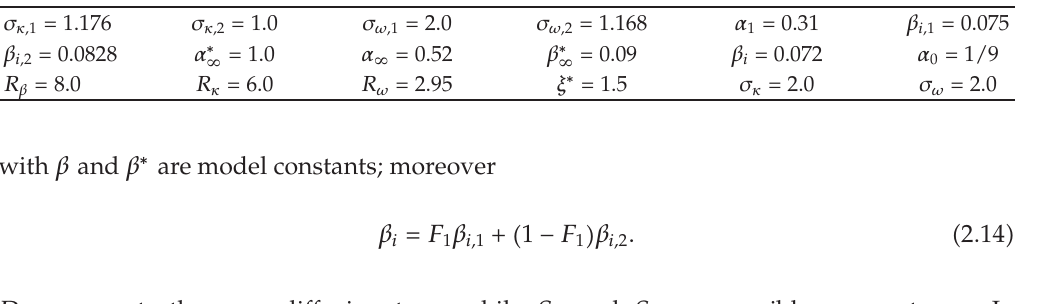
Table 1: Shear stress transport k - ω model